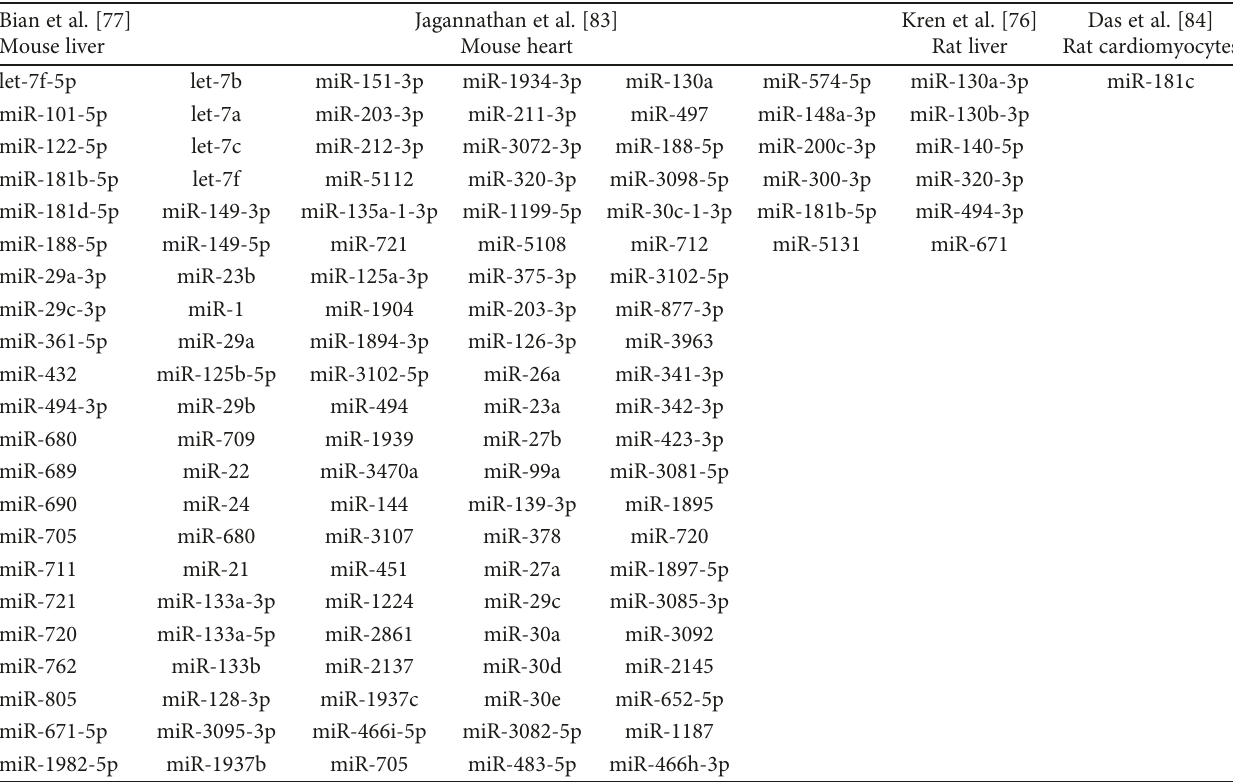
Table 2: List of miRs within mouse and rat